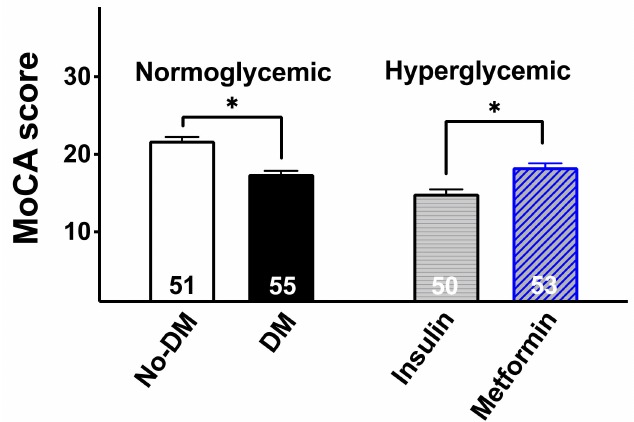
Figure 3. MoCA score in normoglycemic subjects without diabetes mellitus (No-DM), normoglycemic patients with diabetes mellitus (DM), hyperglycemic patients treated with insulin, and hyperglycemic patients treated with metformin. The number within each bar indicates the number of patients/group. Data are means ± SD; *: p < 0.05.